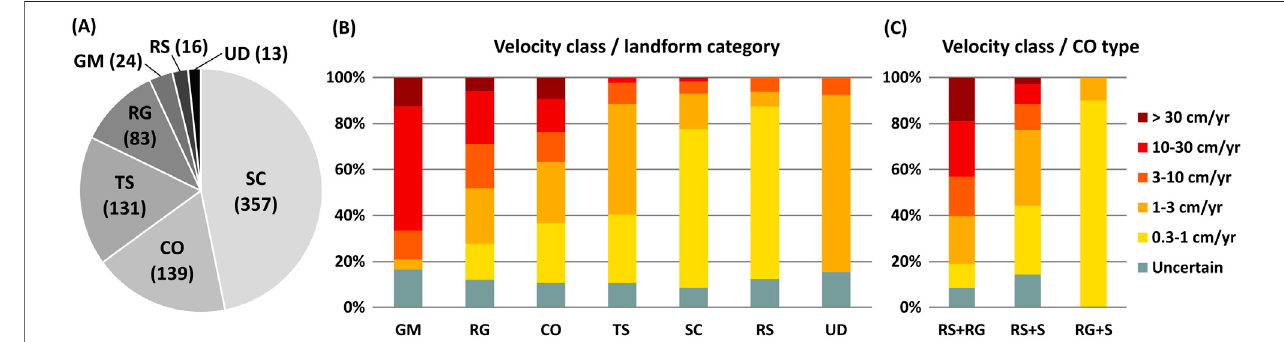
FIGURE 7 | Statistics of the dominant velocity classes per landform category. (A) Number of identi fi ed landforms by landform category . (B) Velocity class by landform category. (C) Velocity class by composite type. Acronyms refer to rock glacier (RG), rockslide (RS), glacier-moraine (GM), talus/scree deposit (TS), soli fl uction/ cryoturbation (SC), composite (CO), unde fi ned (UD) and super fi cial (S). In grey: areas where slope movement has been detected and the landform type categorised but the velocity is uncertain due to location on N – S slopes.